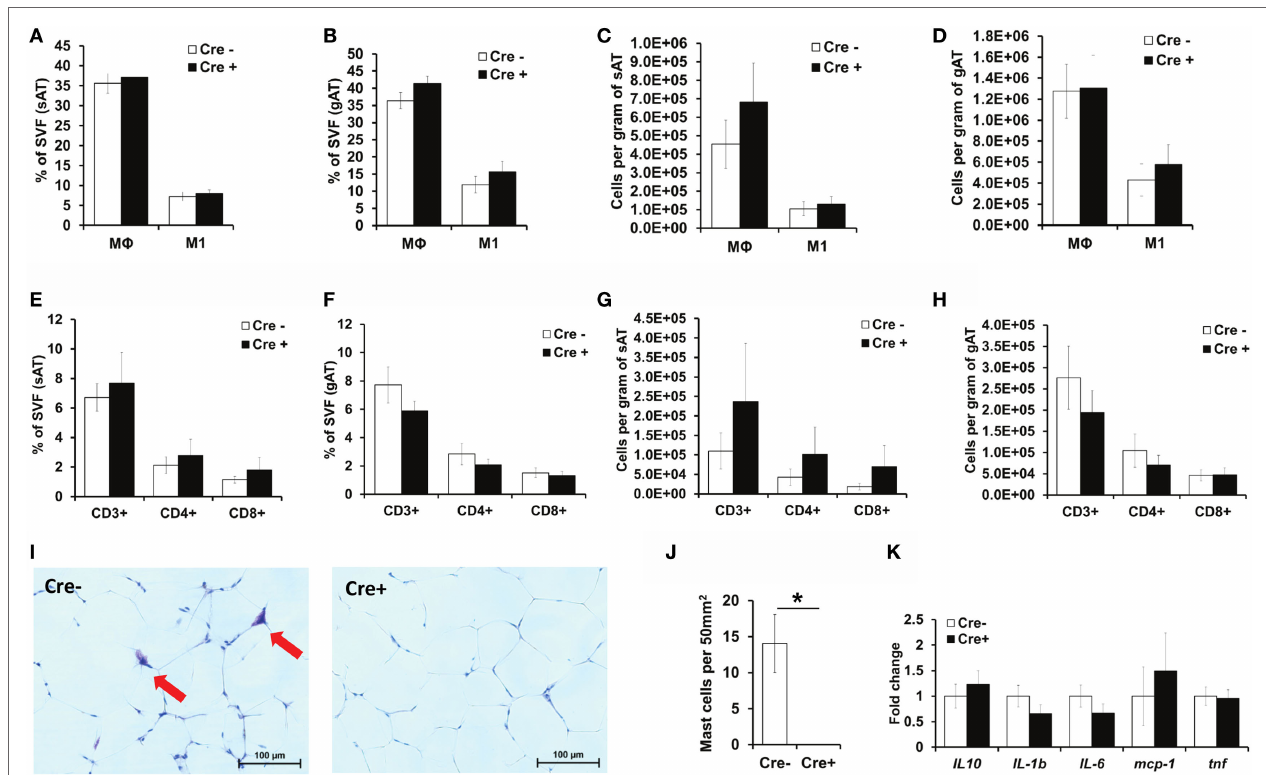
FigUre 3 | no difference in aT inflammation between obese mast cell-deficient and -proficient mice . (a–h) The stromal vascular fraction (SVF) of subcutaneous (sAT) and gonadal (gAT) adipose tissue from obese mast cell-deficient and -proficient mice was analyzed by flow cytometry for the accumulation of total macrophages (M φ s) and pro-inflammatory M1-polarized macrophages. The presence of CD3 + T lymphocytes and of T helper CD4 + and cytotoxic CD8 + T cells was analyzed. Student’s t- test was used for statistical analysis; data are expressed as means ± SEM ( n = at least 8 mice/group). (a,B) Percentual analysis of macrophage accumulation in the sAT (a) and gAT (B) . (c,D) Number of macrophages per gram of sAT (c) and gAT (D) . (e,F) Percentual evaluation of T cell accumulation in the sAT (e) and gAT (F) . (g,h) Number of T cells per gram of sAT (g) and gAT (h) . (i,J) Representative images (Giemsa staining) for the presence of mast cells in the gAT of obese mast cell-deficient and -proficient mice (i) . Mast cell deletion was evaluated (J) ; n = at least 8 mice/group. Mast cells were not present in the AT of Mcpt5-Cre + R-DTA + mice. * p < 0.05. (K) Quantitative PCR analysis of inflammatory gene expression in the gAT of obese mast cell-deficient and -proficient mice. Data are shown relative to the mast cell-proficient mouse group; 18S RNA was used for normalization. Mann–Whitney U test was used for statistical analysis ( n = 8